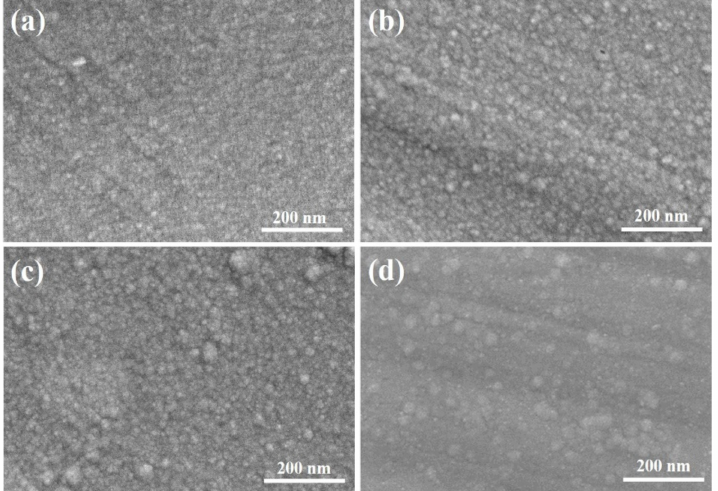
Figure 3. SEM surface micrographs of Ni-Mo coatings: ( a ) as-deposited and annealed at ( b ) 200 ◦ C,